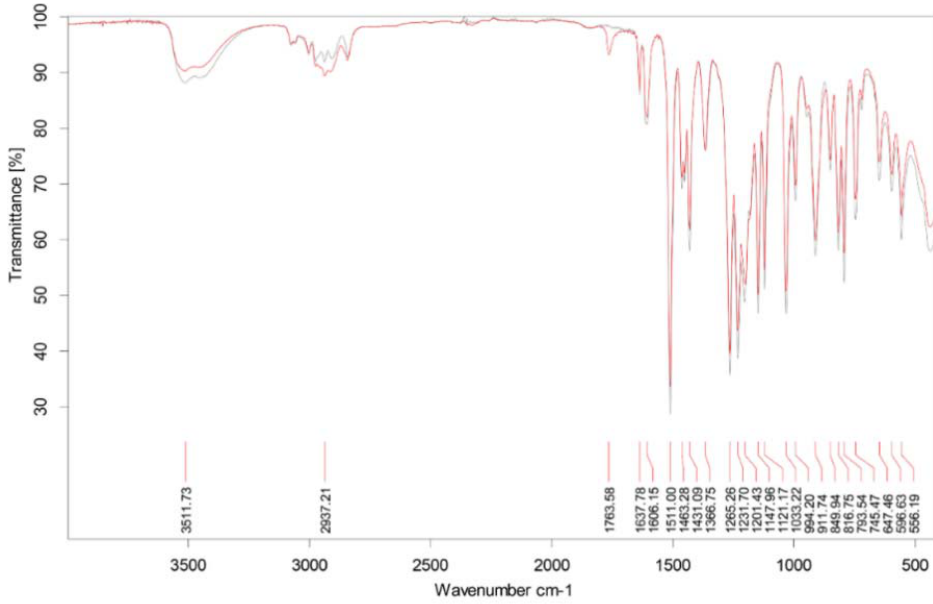
Figure 1. ATR-FTIR spectra for CEO and EUG. Figure 1. ATR ‐ FTIR spectra for CEO and EUG.